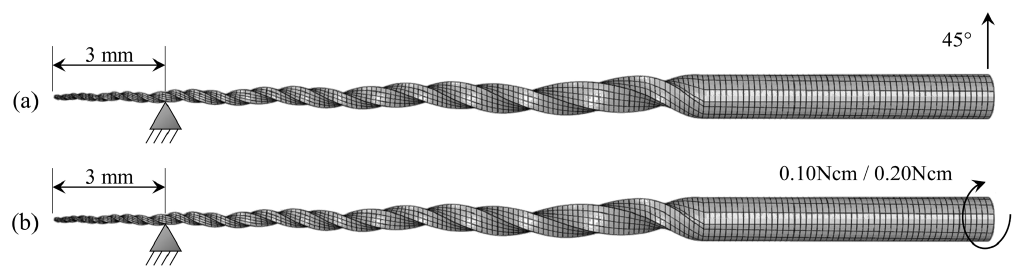
Figure 2. Boundary conditions used for (a) the bending and (b) torsion test, based on ISO 3630-1 31